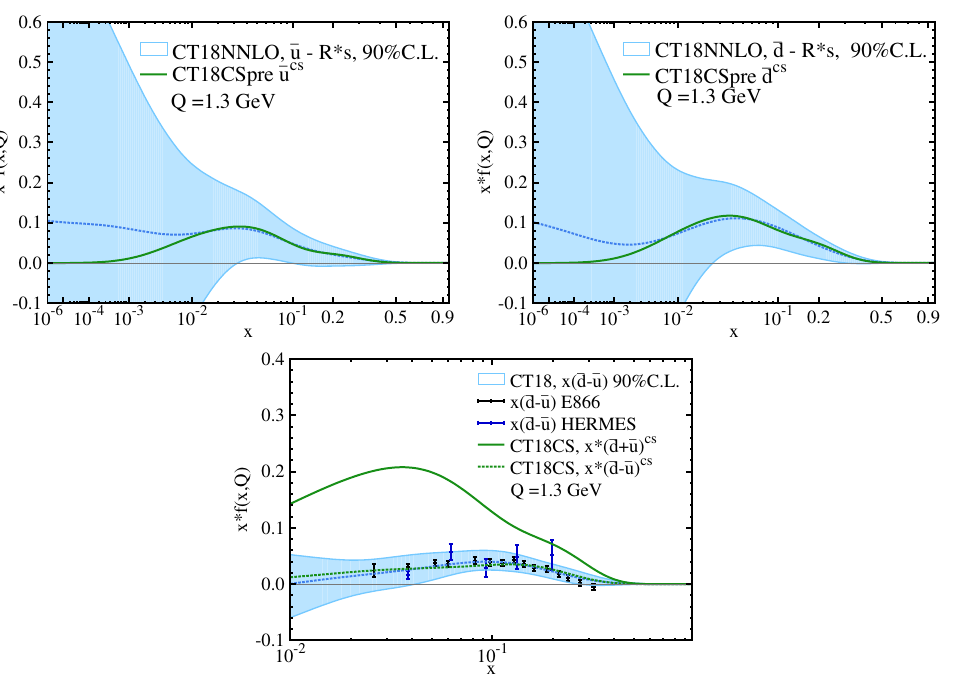
Figure 2: The upper panel shows the CS components of the up- and down- antiquark distributions in CT18CSpre (green curves), which are compared to the prediction of CT18NNLO (blue dashed lines for central values and blue regions for the error bands at 90% confidence level) on ( ¯ u − R ∗ s ) and ( ¯ d − R ∗ s ) , respectively. The lower panel compares x ( ¯ d − ¯ u ) of CT18NNLO and x ( ¯ d cs − ¯ u cs ) of CT18CSpre to